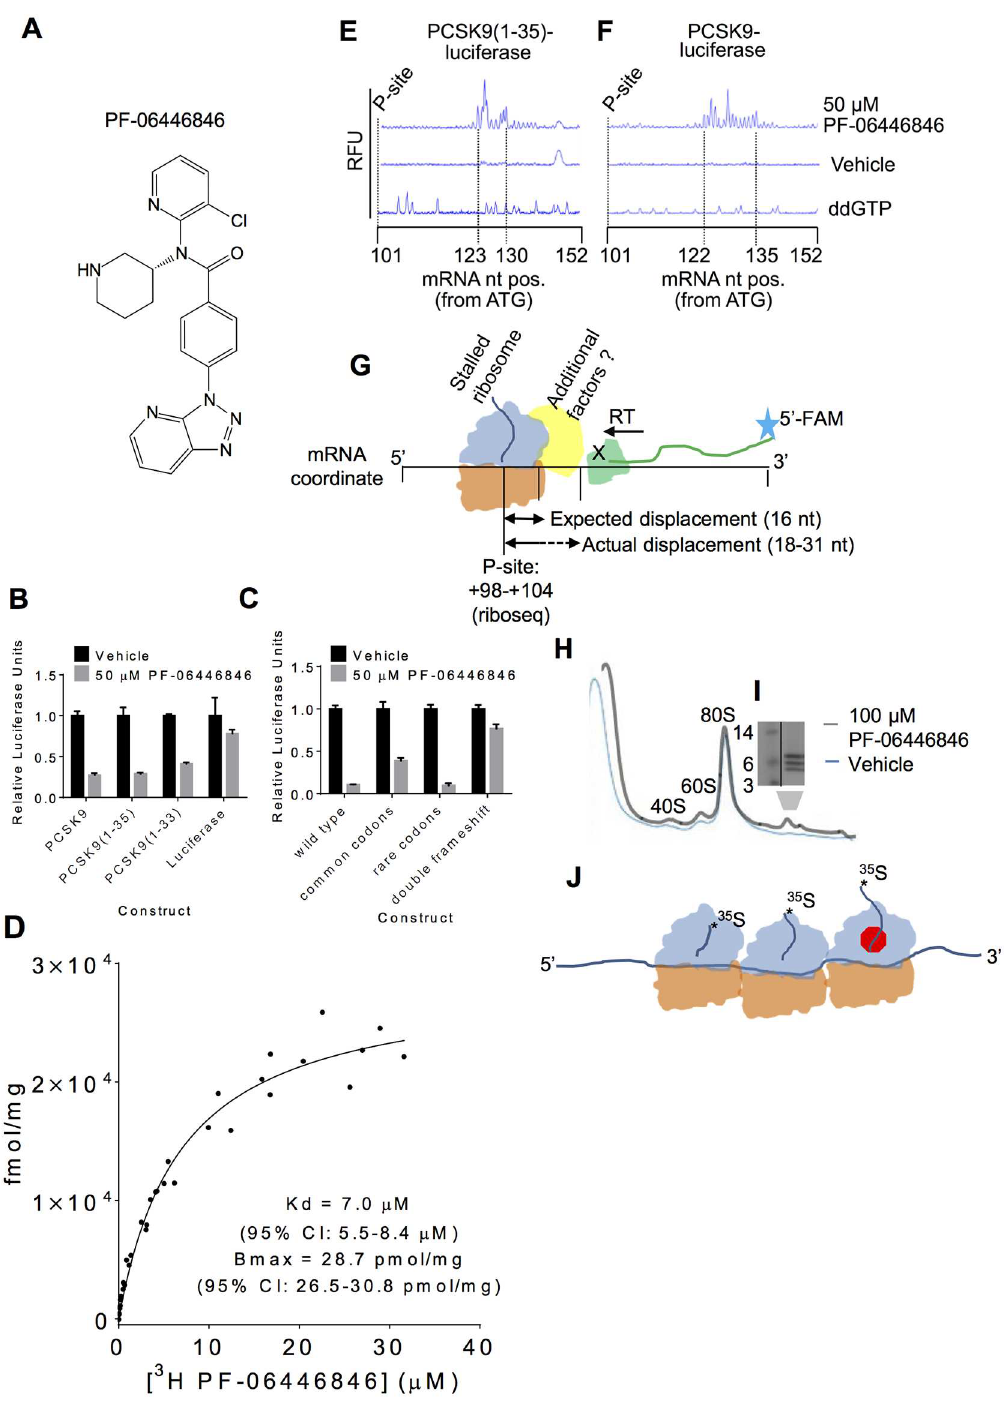
Fig 1. PF-06446846 targets the human ribosome, inducing stalling during proprotein convertase subtilisin/ kexin type 9 (PCSK9) translation. (A) Structure of PF-06446846. (B) Luciferaseactivity of HeLa-based cell-free translation reactions programmed with mRNAs encodingPCSK9-luciferase,PCSK9(1–35)-luciferase,and PCSK9 (1–33)-luciferase fusions and luciferase alone in the absence(black bars) or presence (grey bars) of 50 μ M PF- 06446846.All error bars represent one standard deviationof three replicates. (C) PF-06446846 sensitivity dependence on the amino acid sequenceof PCSK9(1–33). PCSK9-luciferasefusions encodethe native PCSK9 amino acid sequencewith common codons or rare codons or a native, double-frameshifted mRNA sequencethat results in a changedamino acid sequence(See S1E Fig for sequences). All error bars represent one